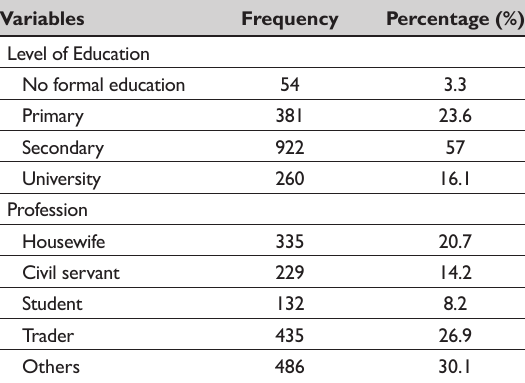
Table 2: Distribution by level of education and